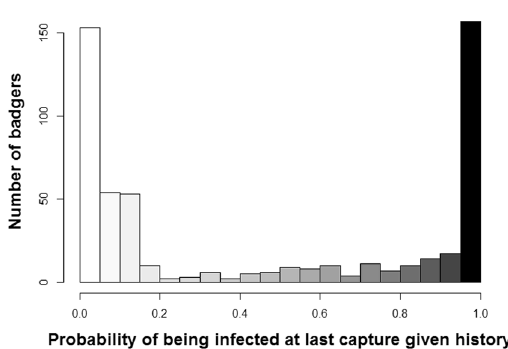
Figure 4. Distribution of the probability of being infected in the Woodchester Park badger population at the time of last capture of each individual, given its capture and testing history. Approximately 70% of subjects in the study population had probabilities of being infected at their last capture that were higher than 0.95 (black bar) or lower than 0.05 (white bar), meaning that the infection status of the remaining 30% of badgers was less certain. Note that the 5% and 95% thresholds are used here arbitrarily: any cut-off could be selected depending on the degree of certainty